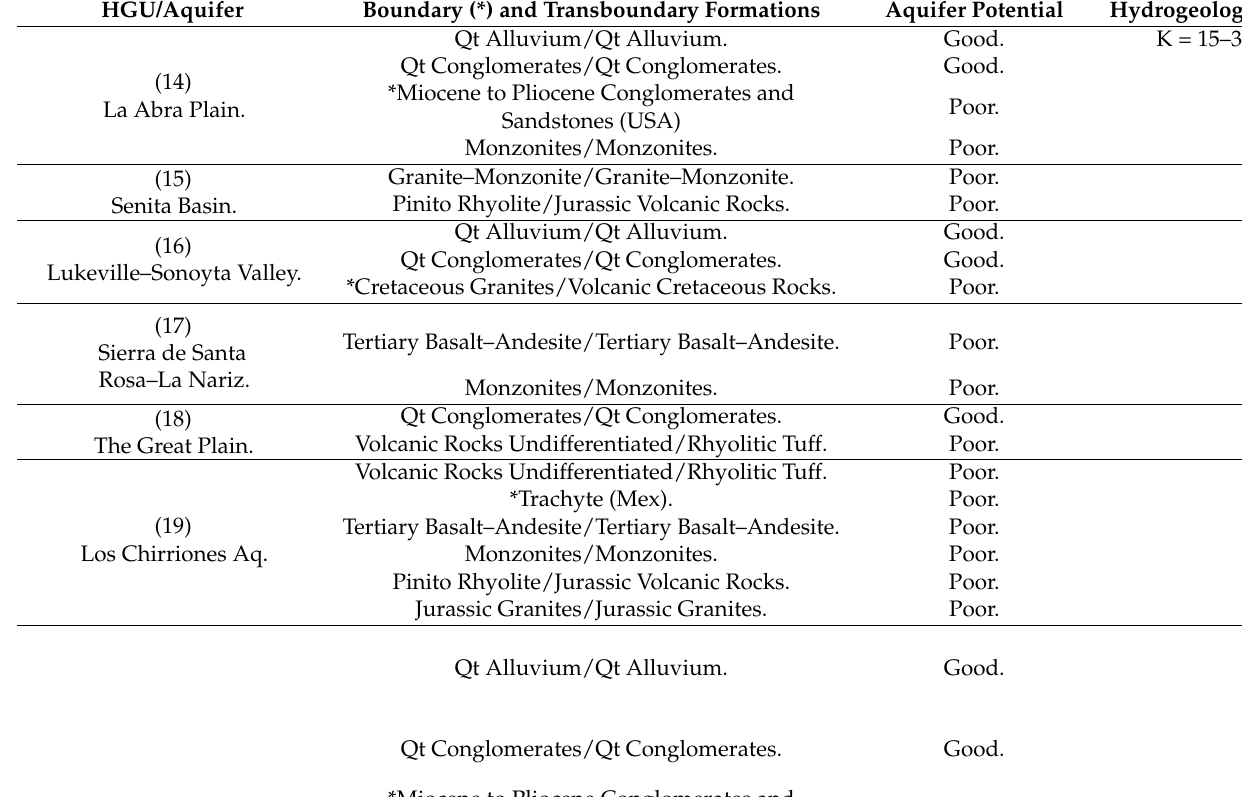
Table 3. Classification of geological formations (within their corresponding HGU) in the border region between California,